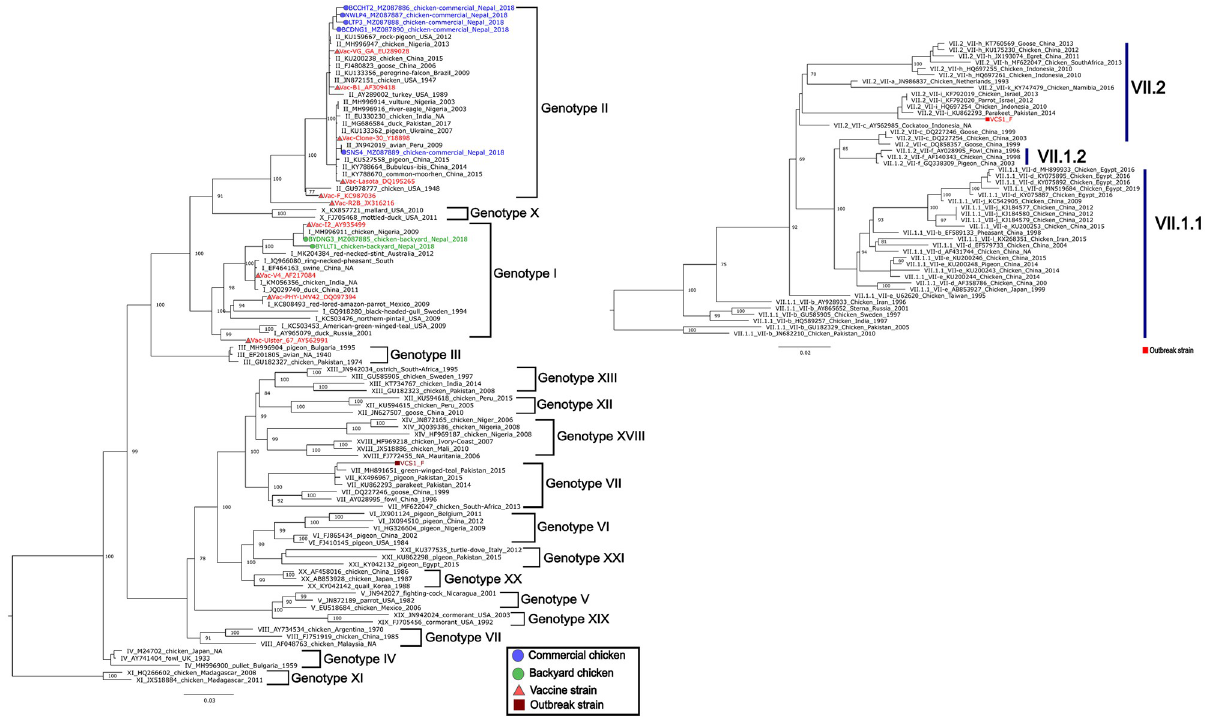
Fig 7. Phylogenetic analysis of the partial NDV Fusion gene (744 bp) of the 2021 outbreak strain (brown color, MZ087884.1) clustered it in the Genotype VII group. Further phylogenetic analysis placed the outbreak strain (red) in the Genotype VII.2 group [47].